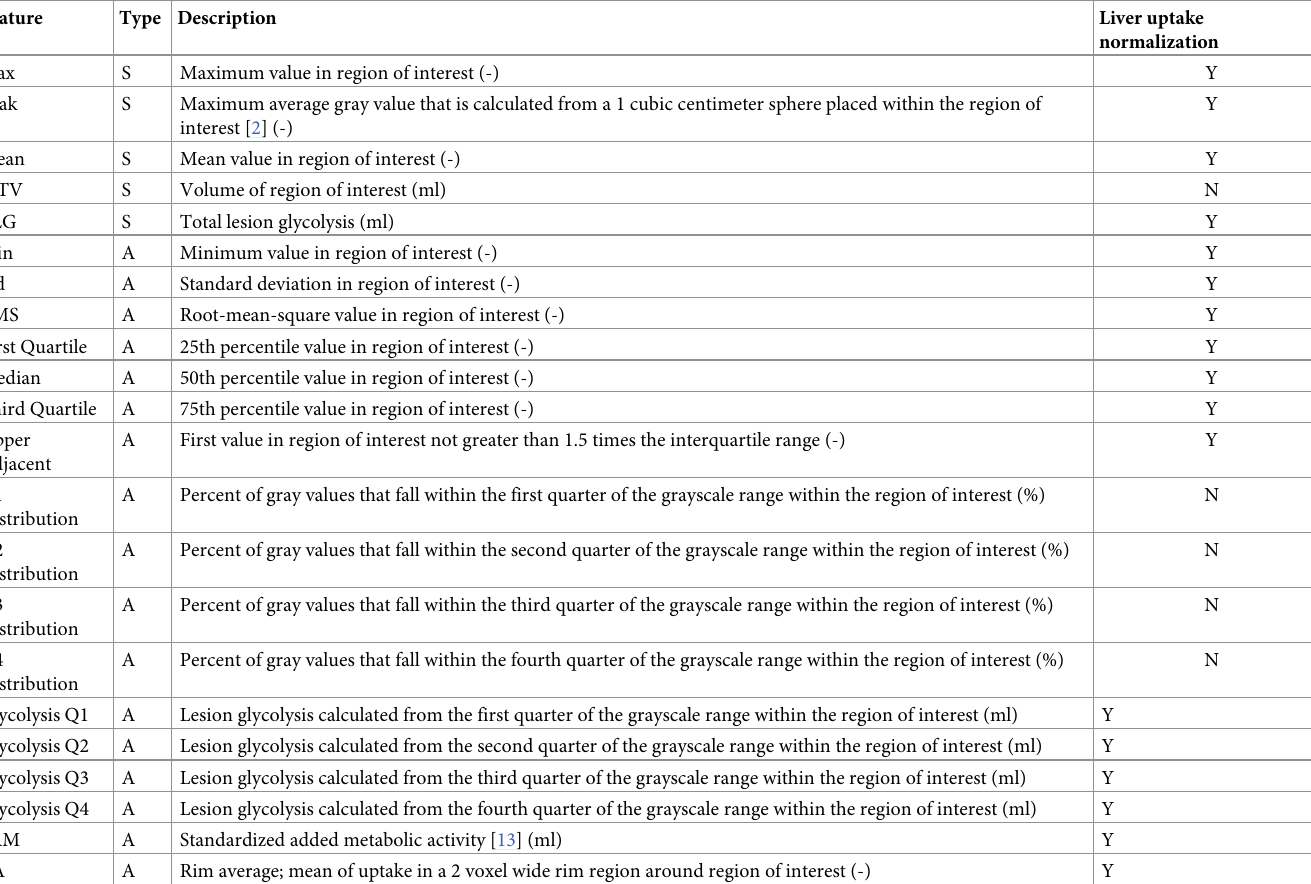
Table 2. Overview of image-derived features